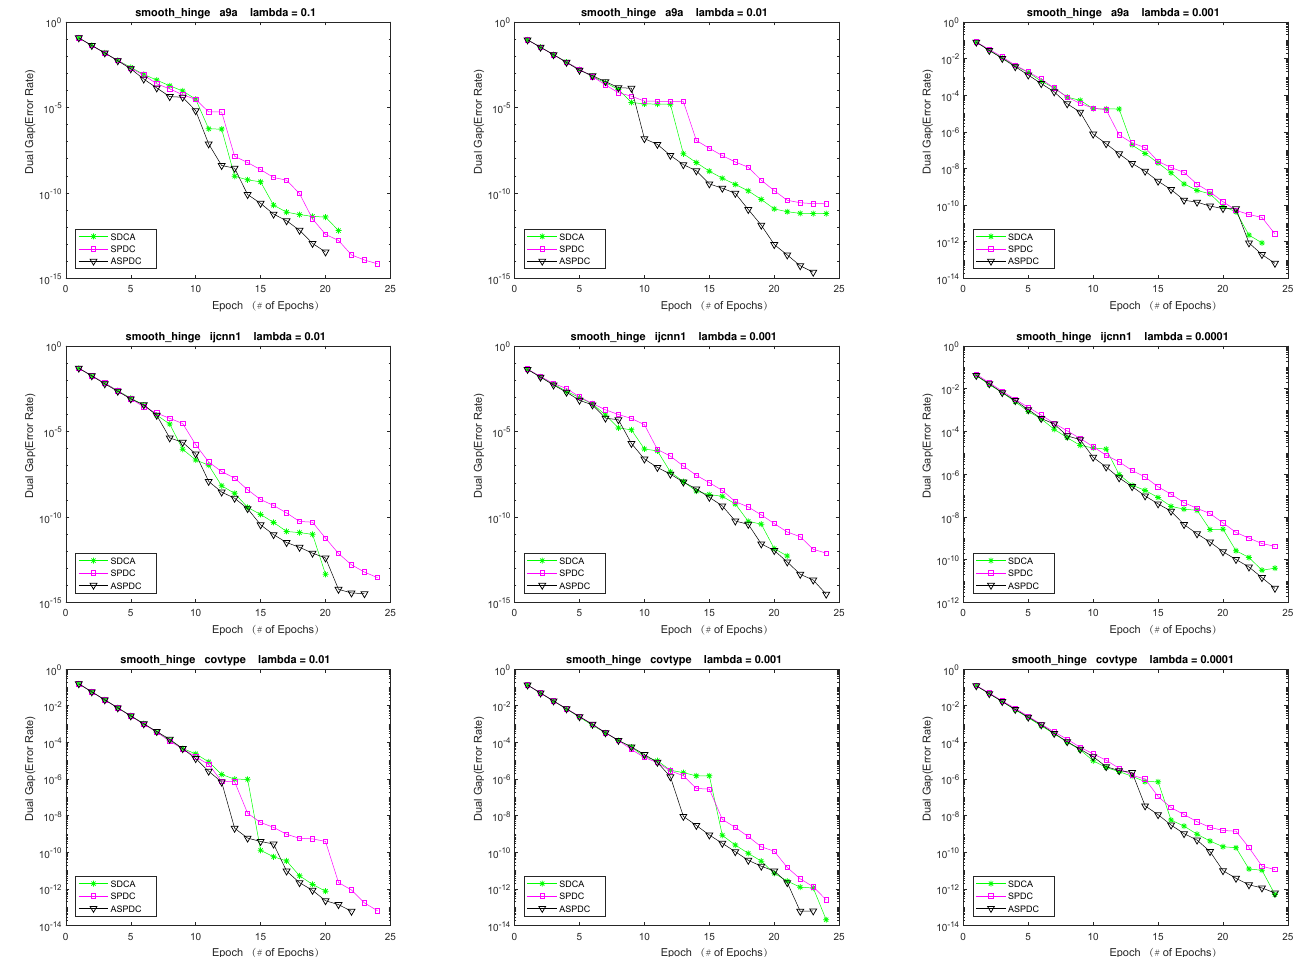
Figure 1. Dual-gap ( y -axis) vs, the number of epochs ( x -axis). Comparing ASPDC with other methods for smooth hinge SVM on real-world datasets with regularization coefficient λ ∈ { 0.1,0.01,0.001,0.0001 } . The horizontal axis is the number of passes through the entire dataset, and the vertical axis is the logarithmic